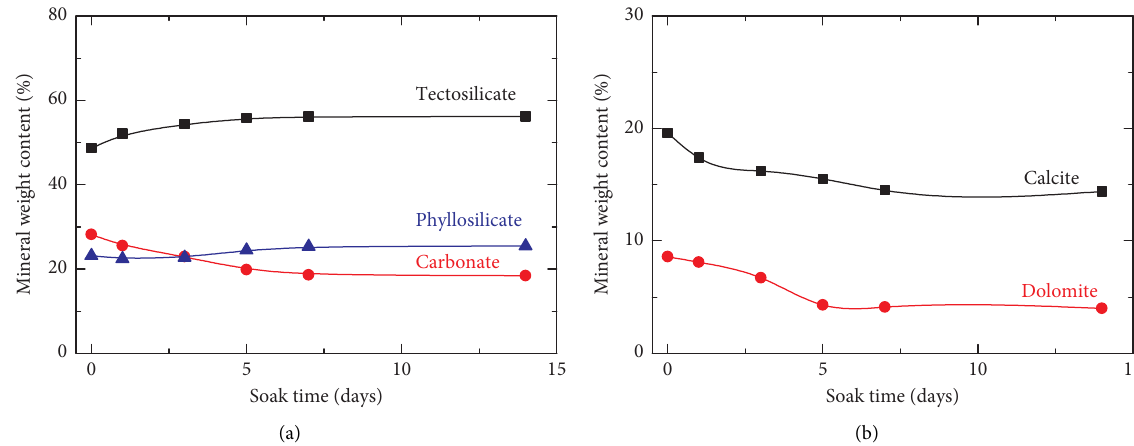
Figure 4: The mineralogical compositions evolution due to CO 2 soak. The tectosilicate minerals include quartz, analcime, anorthite, albite, and microcline. The carbonate minerals include carbonate and dolomite. The phyllosilicate minerals include muscovite, illite, chlorite, kaolinite, and montmorillonite. (a) The mineral weight content change due to the CO 2 soak. (b) The mineralogical content evolution of calcite and